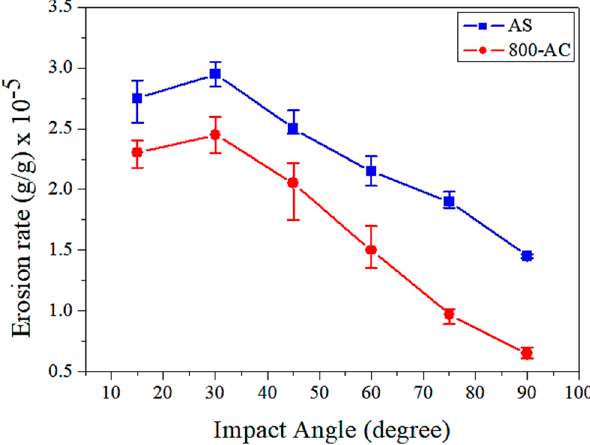
Figure 11. The erosion rate as a function of the impact angles of AS and 800-AC.